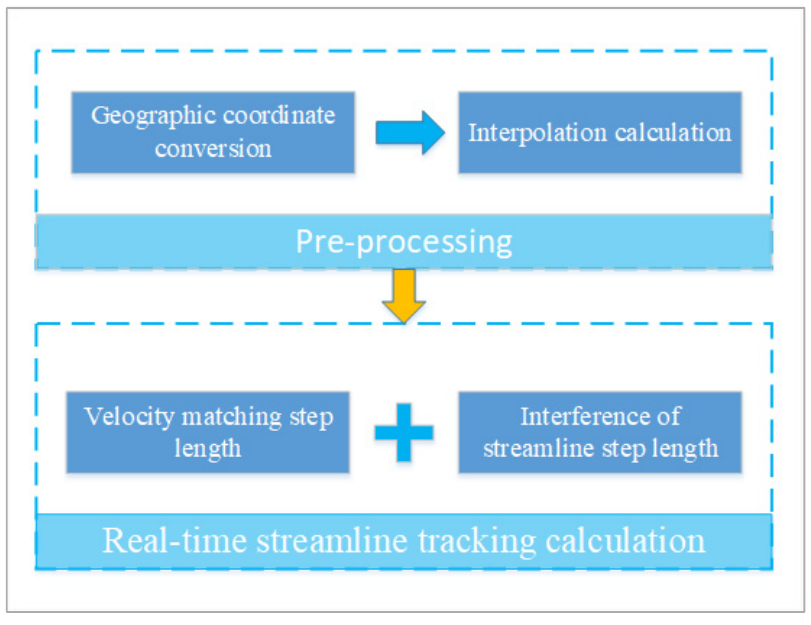
Figure 1. Workflow of real-time streamline tracking algorithm based on screen coordinate system. The real-time streamline tracking algorithm combines velocity matching and step length intervention to adaptive the streamline step length in multi-scale.